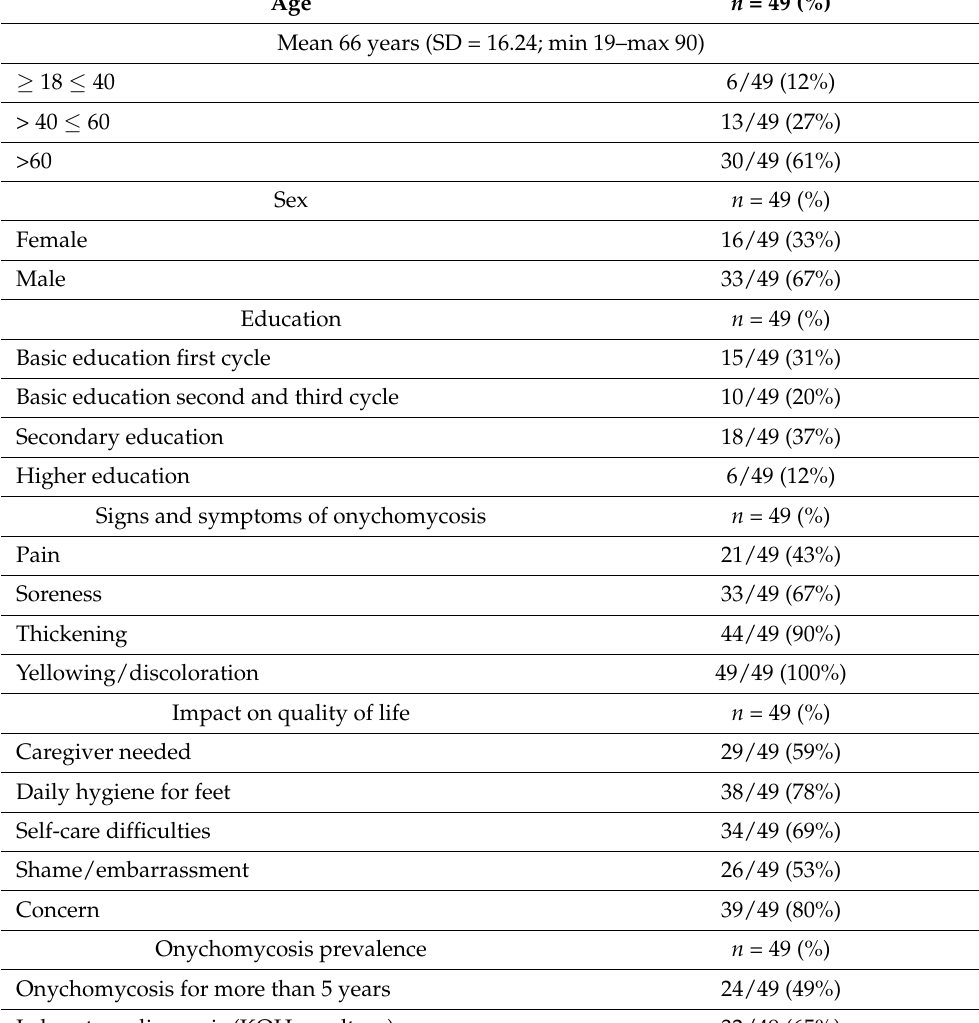
Table 2. Demographic and clinical